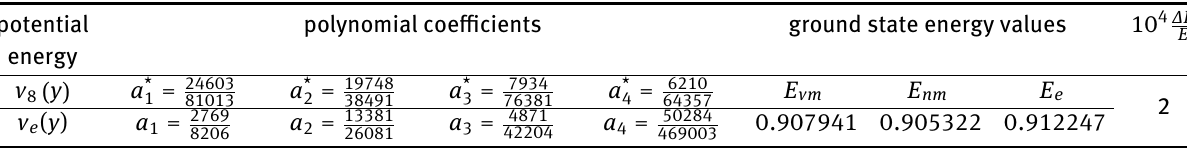
Table 8: Physical parameters for the potential energy v 8 ( y ) = y 3 + y 4